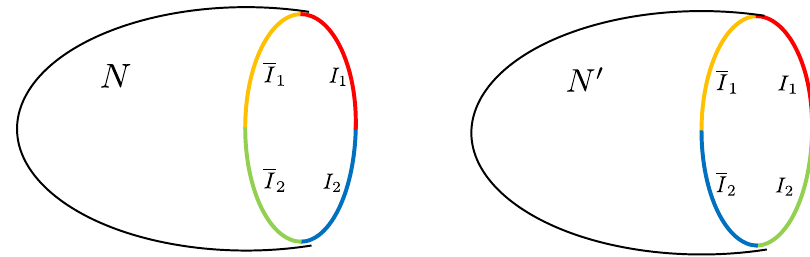
Figure 4 . Taking tr I ( (cid:26) I (cid:26) T 1 ) amounts to gluing N and N 0 along boundaries, such that the boundary I 1-simplices with the same color in the (cid:12)gure are identi(cid:12)ed. We are gluing I 1 + I 1 (red and yellow curves) by the orientation reversing map, and I 2 + I 2 (blue and green curves) by the orientation preserving map. The resulting surface X has a crosscap introduced along I 1 + I 1